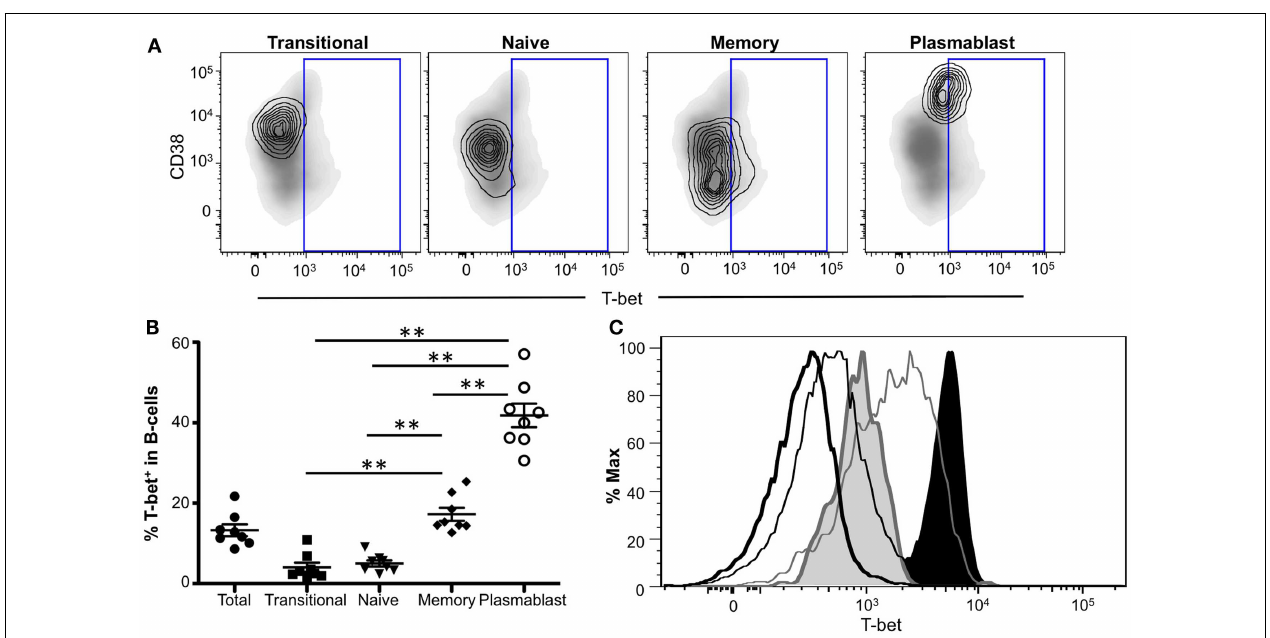
of interest, as measured using non-parametricWilcoxon matched, paired two-tailed t tests, are described in the text. * p < 0.04. (C) Histograms depictingT-bet expression levels in B-cells and NK cells from a representative donor. Histograms represent the following subsets: naïve B-cells (thick black line), memory B-cells (thin black line), plasmablasts (shaded gray), CD56 bright NK cells (gray line), and CD56 dim NK cells (shaded